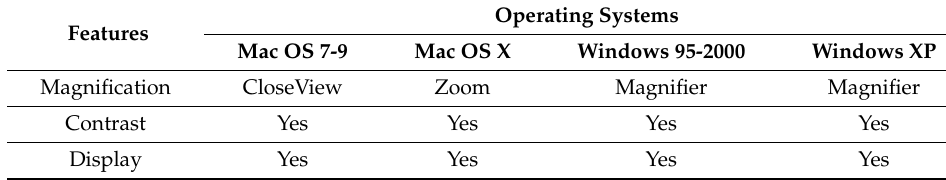
Table 12. OS and their features from